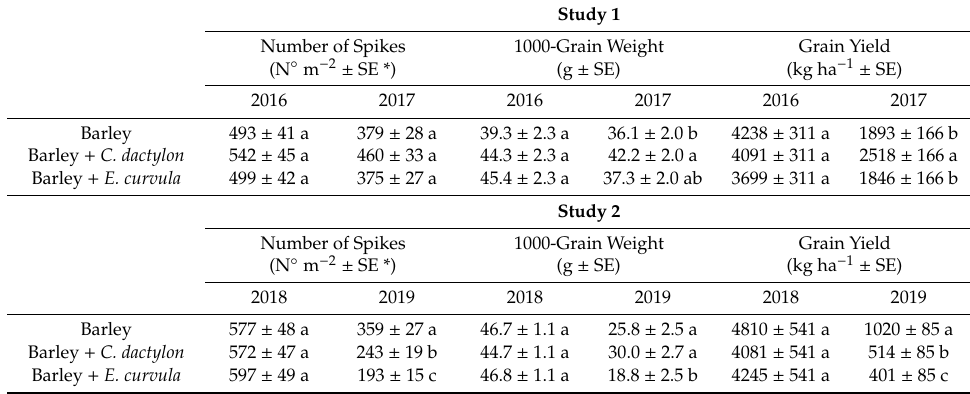
Figure 2. Monthly rainfall (mm) and temperature ( ◦ C), as well as the average of the 15-year series (2004–2018) for Arganda del Rey for ( a ) Study 1, 2016 and 2017; ( b ) Study 2, 2018 and 2019. Table 3. Barley yield parameters (number of spikes, grain weight per spike and grain yield) in the three treatments in Studies 1 and